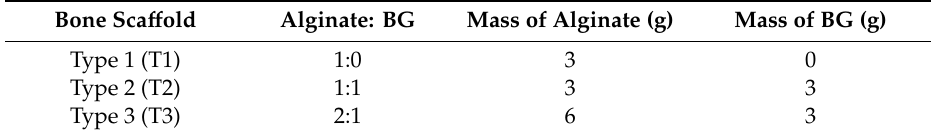
Table 2. Showing the weight ratio of alginate and bioactive glass (BG) A1 in three types of bone sca ff